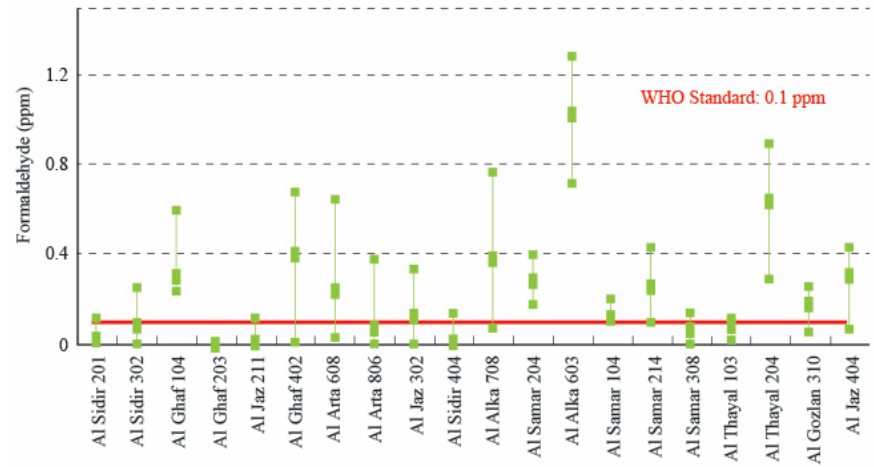
Figure 7. Formaldehyde (CH 2 O) concentrations in 20 housing units at The Greens, Dubai.